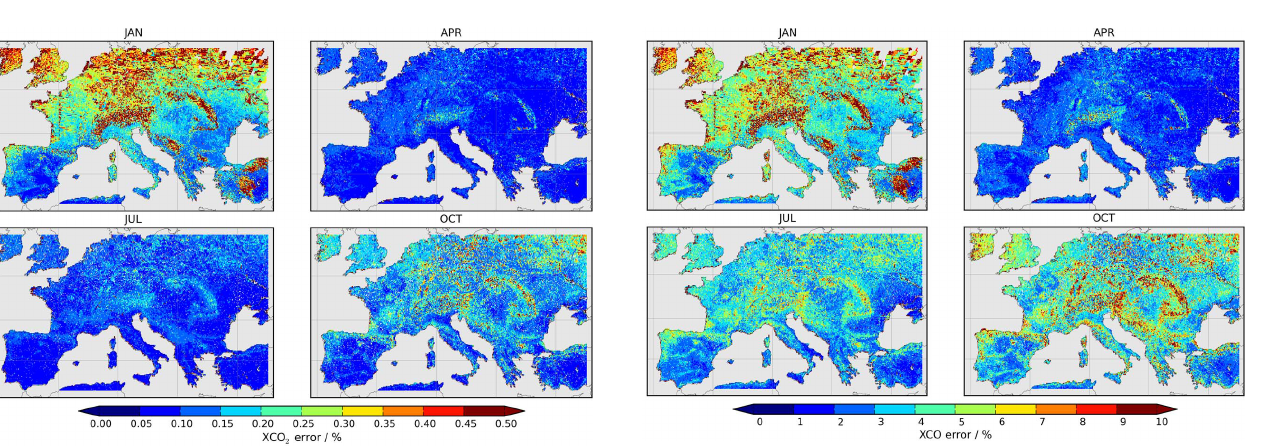
Figure 6. Relative XCO 2 noise error among the European trial en- semble expected from G3E for the months January (JAN), April (APR), July (JUL), and October (OCT).